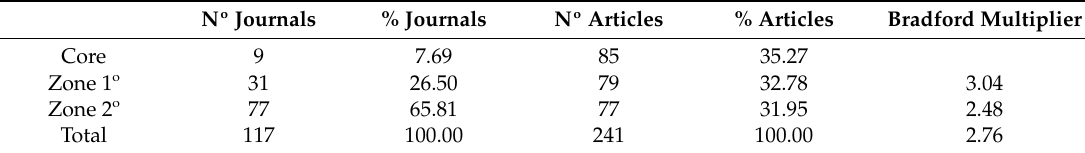
Table 4. Distribution of journals in Bradford’s